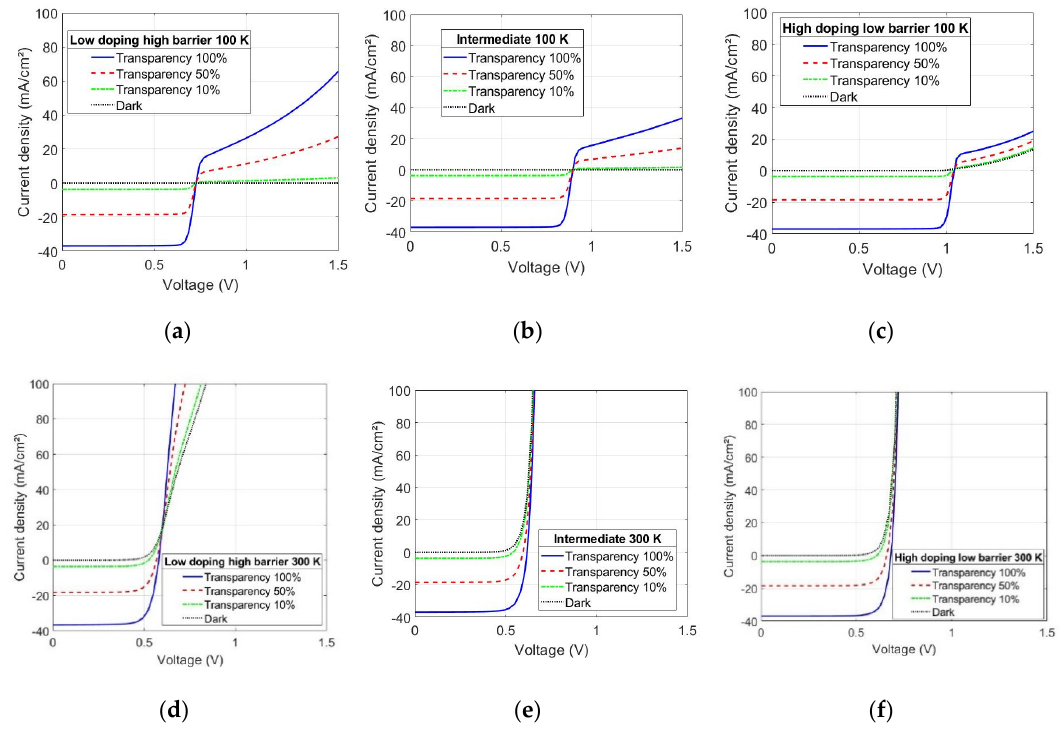
Figure 6. Simulated current density–voltage (J–V) curves at 100 K for ( a ) CIGS doping of 7 × 10 14 cm − 3 and a barrier of 460 meV, ( b ) doping of 1 × 10 15 cm − 3 and barrier of 300 meV and ( c ) doping of 1 × 10 16 cm − 3 and barrier of 200 meV. The same parameters are considered in ( c – e ), respectively, for the simulations at 300 K.